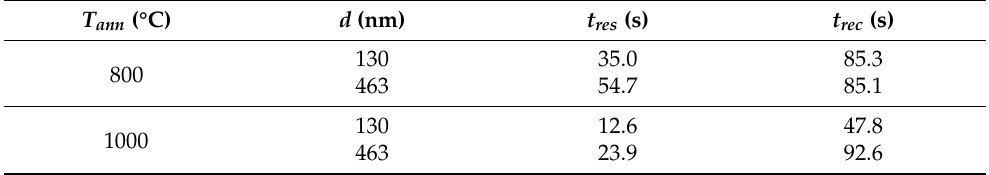
Figure 4. Time dependences of the TiO 2 thin films resistances upon exposure to 40 vol. % O 2 and T oper = 750 ◦ C. Table 3. Response and recovery times of TiO 2 thin films upon exposure to 40 vol. % O 2 and T oper = 750 ◦